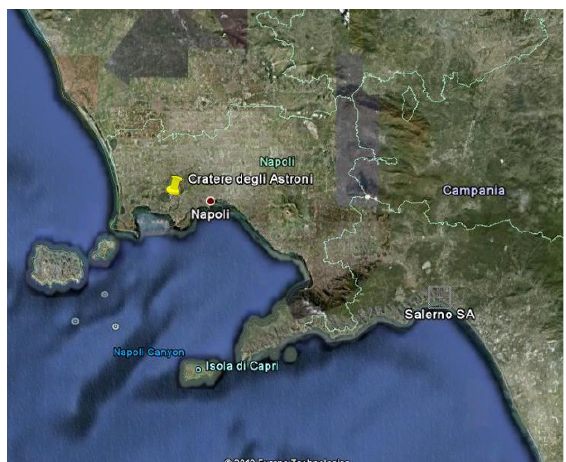
Figure 1. The map shows the location of the sampling sites in the Campania Region.